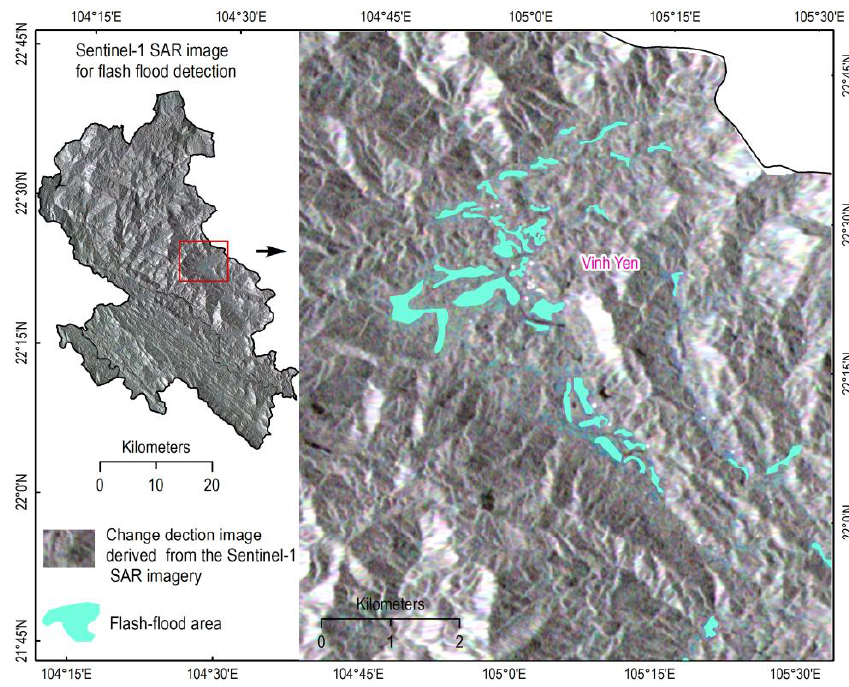
Figure 2. Flash flood areas detected from the Sentinel-1 SAR images.